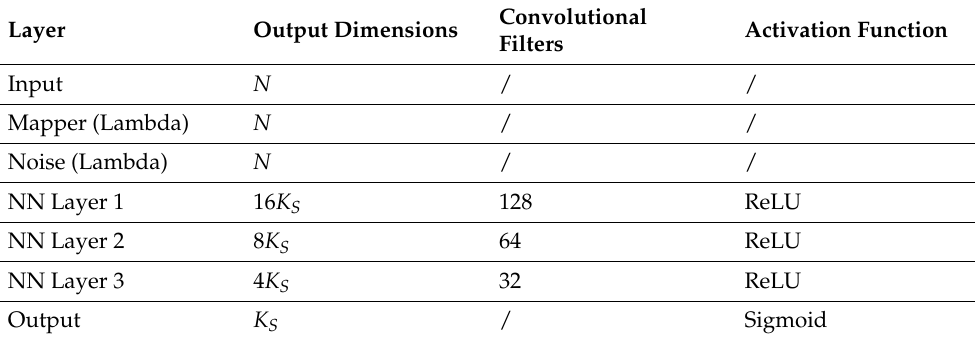
Table 1. The structure of the NN.